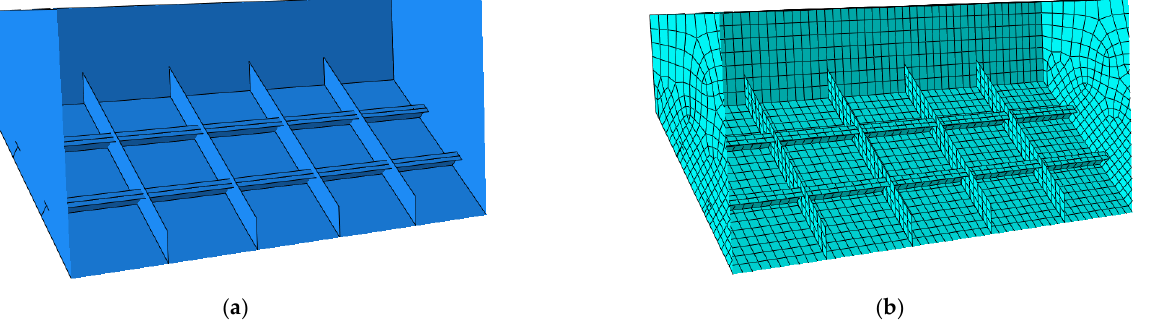
Figure 7. FE model of the wedge structure. ( a ) arrangement of local structures. ( b ) mesh generation.